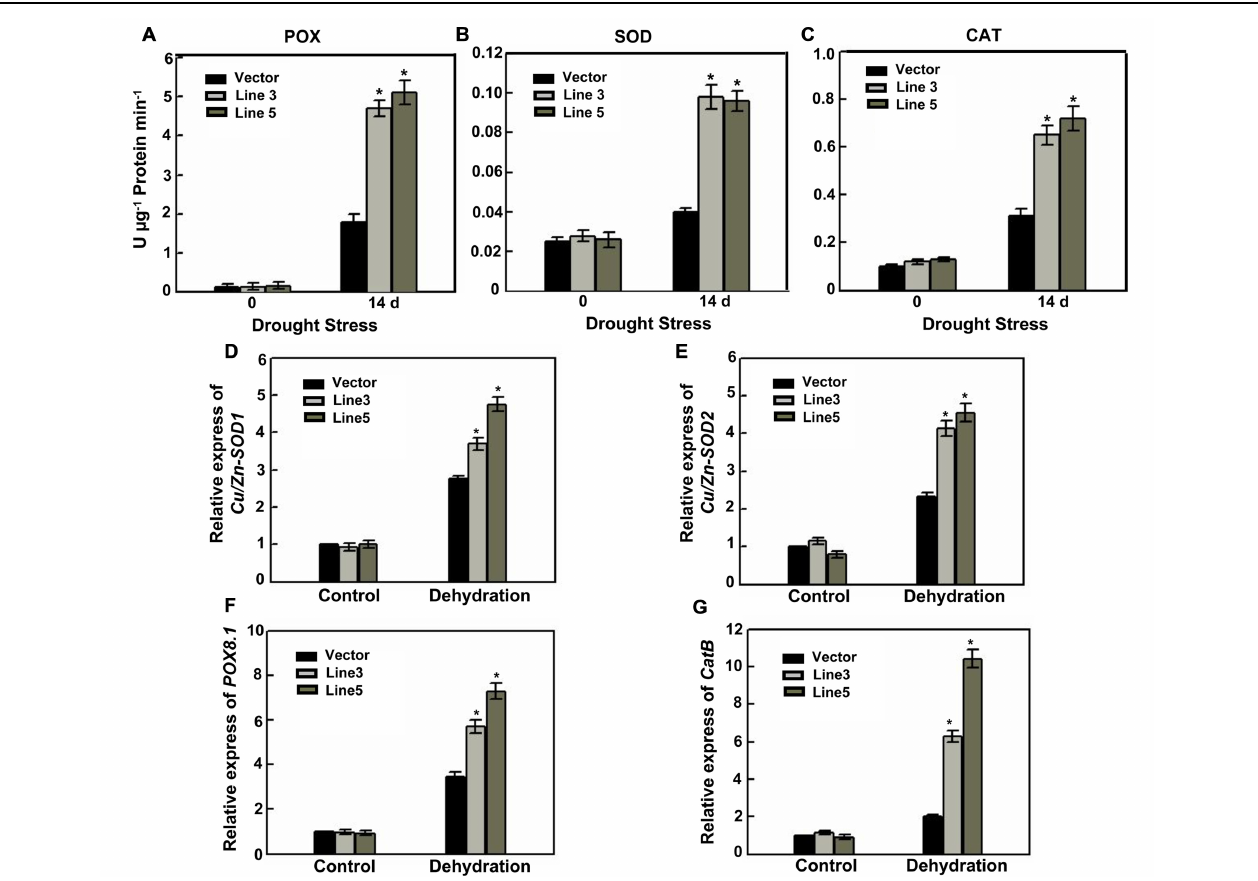
FIGURE 3 | Enhanced the ROS-scavenging ability and the expression of oxidative enzymes genes in transgenic rice. (A–C) POX, SOD, and CAT activities in the leaves of 4-week-old transgenic and control plants before and after drought stress. Values are the mean ± SE of three independent experiments ( ∗ P < 0.05). FW, Fresh weight. Relative expression of oxidative enzymes genes Cu/Zn-SOD1 (D) , Cu/Zn-SOD2 (E) , POX8.1 (F) , and CatB (G) in the leaves of 4-week-old transgenic and control plants before and after drought stress. Values are the mean ± SE of three independent experiments ( ∗ P <